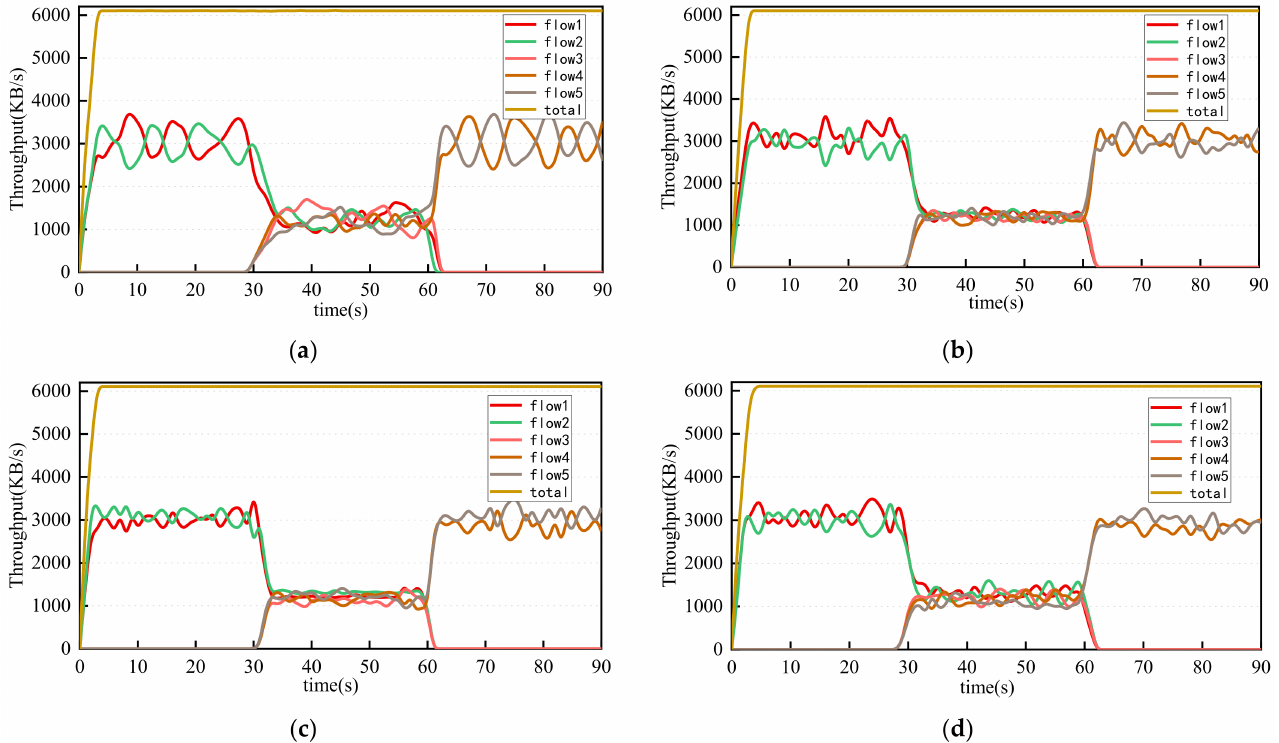
Figure 8. The fairness of the transport protocol in deploying different queue management algorithms: ( a ) Drop Tail; ( b ) RED; ( c ) CoDel; ( d ) Improved